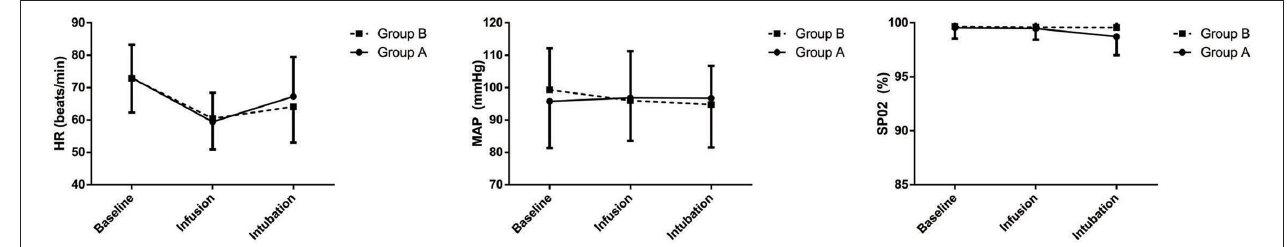
FIGURE 2 | Heart rate (HR), mean arterial blood pressure (MAP), and peripheral oxygen saturation (SpO 2 ) before premedication (baseline), immediately after drug infusion (infusion), and immediately after intubation (intubation). Group A: Topical anesthesia; Group B: Cricothyroid membrane puncture anesthesia. Points are expressed as mean ±